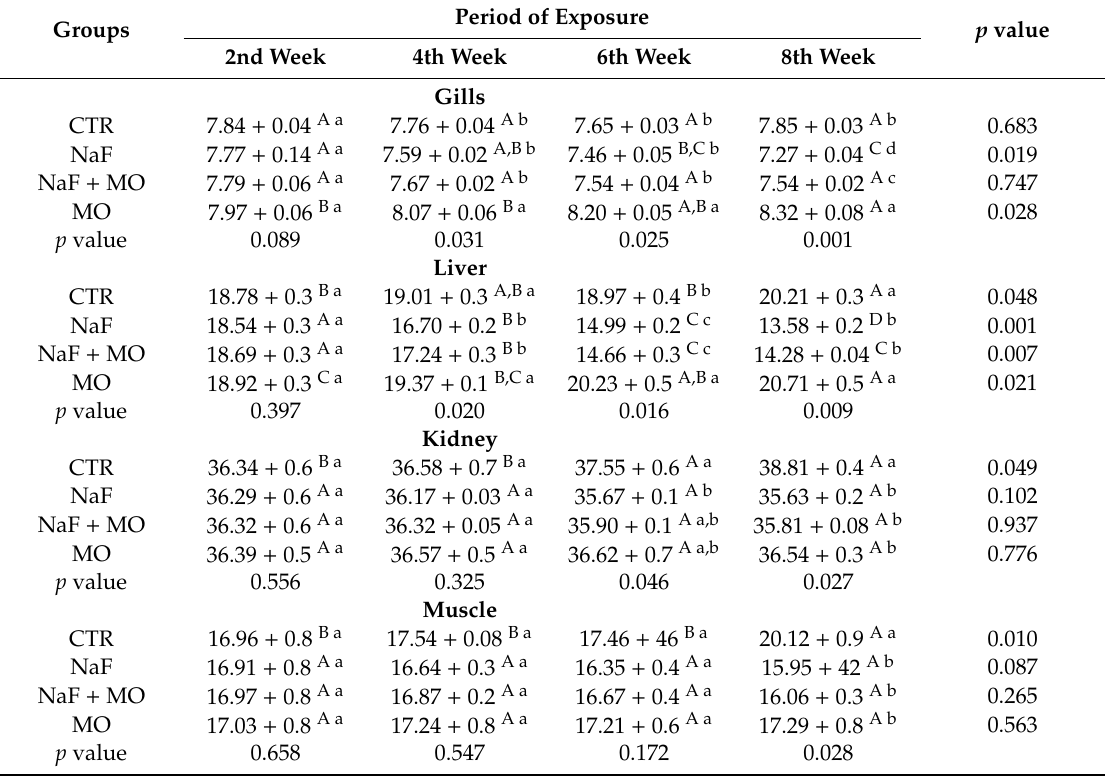
Di ff erent superscript small letters within the same column indicate significantly di ff erent mean values between di ff erent groups. Di ff erent superscript capital letters within the same row indicate significantly di ff erent mean values between di ff erent periods of exposure. CTR, control; NaF, sodium fluoride (6.1 mg / L.); NaF + MO, sodium fluoride (6.1 mg / L) + Moringa oleifera extract (1% in ration); MO, M. oleifera extract (1% in